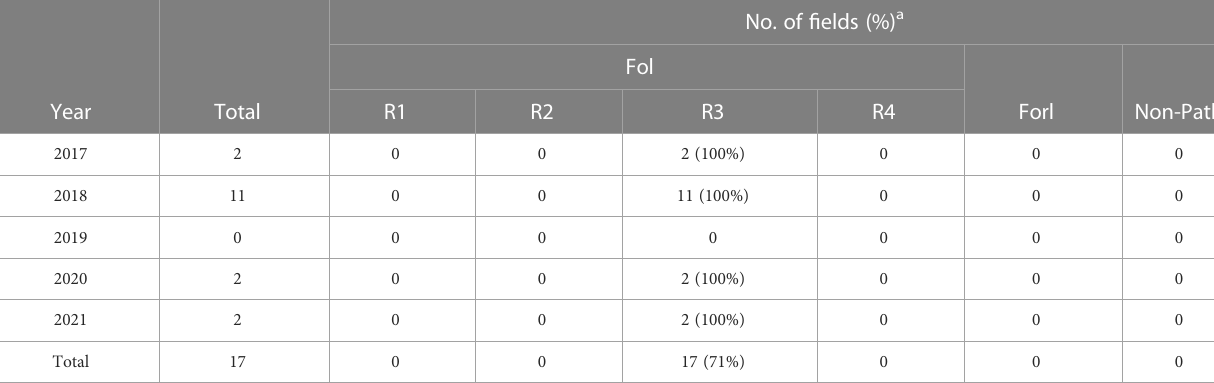
TABLE 8 Outcome of Fusarium oxysporum f. sp. lycopersici (Fol) race 4 statewide monitoring in California processing tomatoes over 5 years: from 2017 to